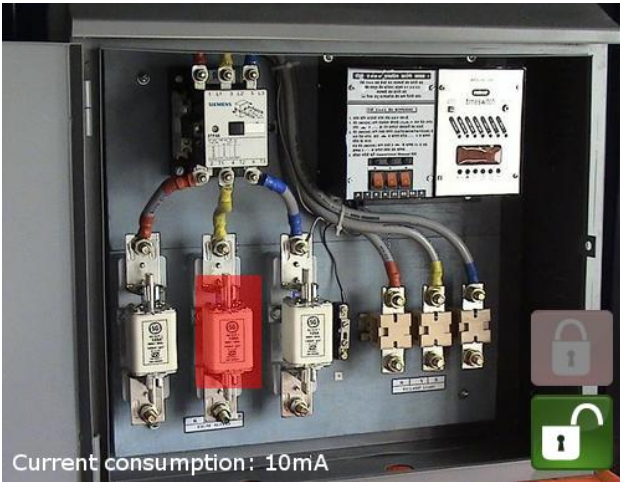
Figure 13. Example of a detailed view with available connections and related controls.